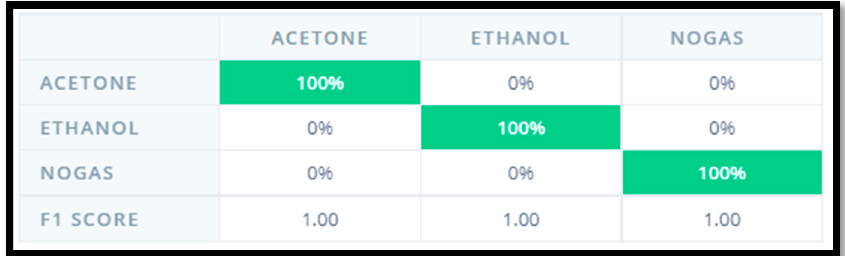
Figure 6. The confusion matrix. 100% success was achieved on the test set.